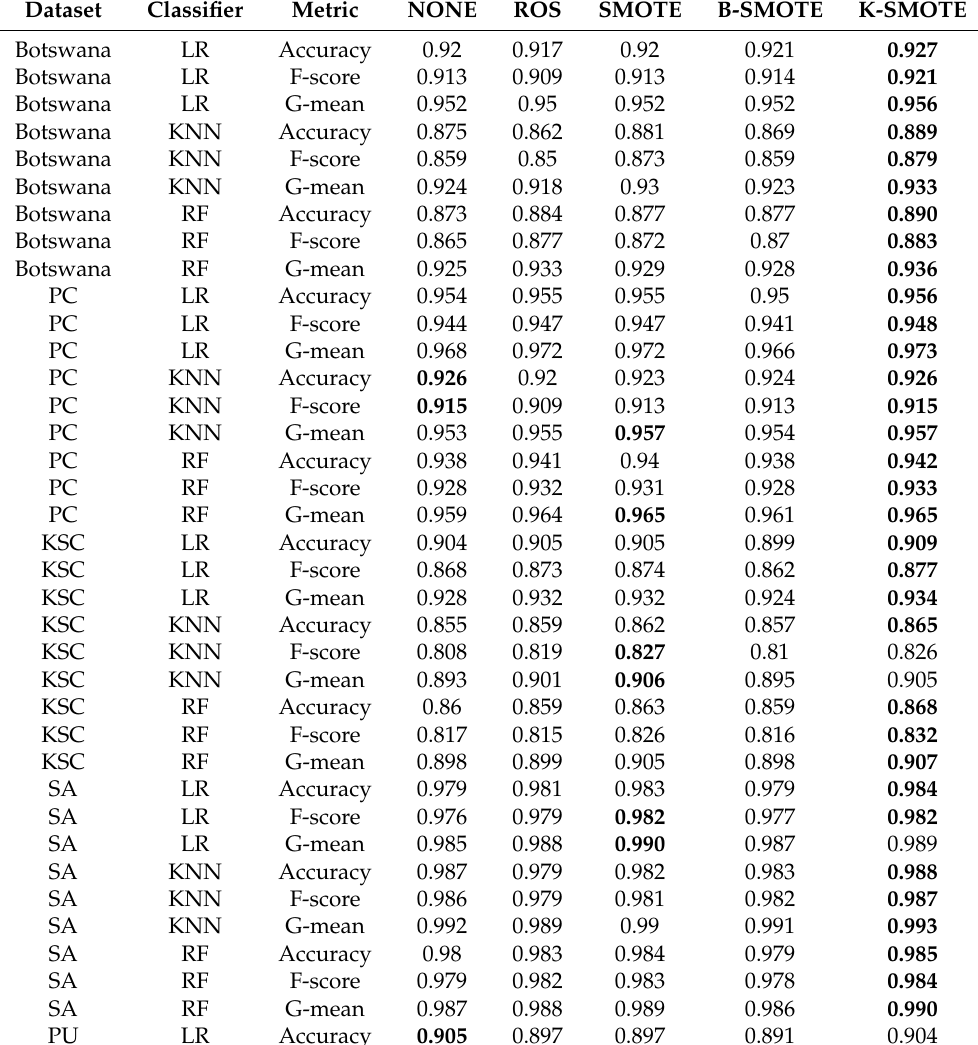
Table A1. Mean cross-validation scores for each dataset. Legend: IP—Indian Pines,